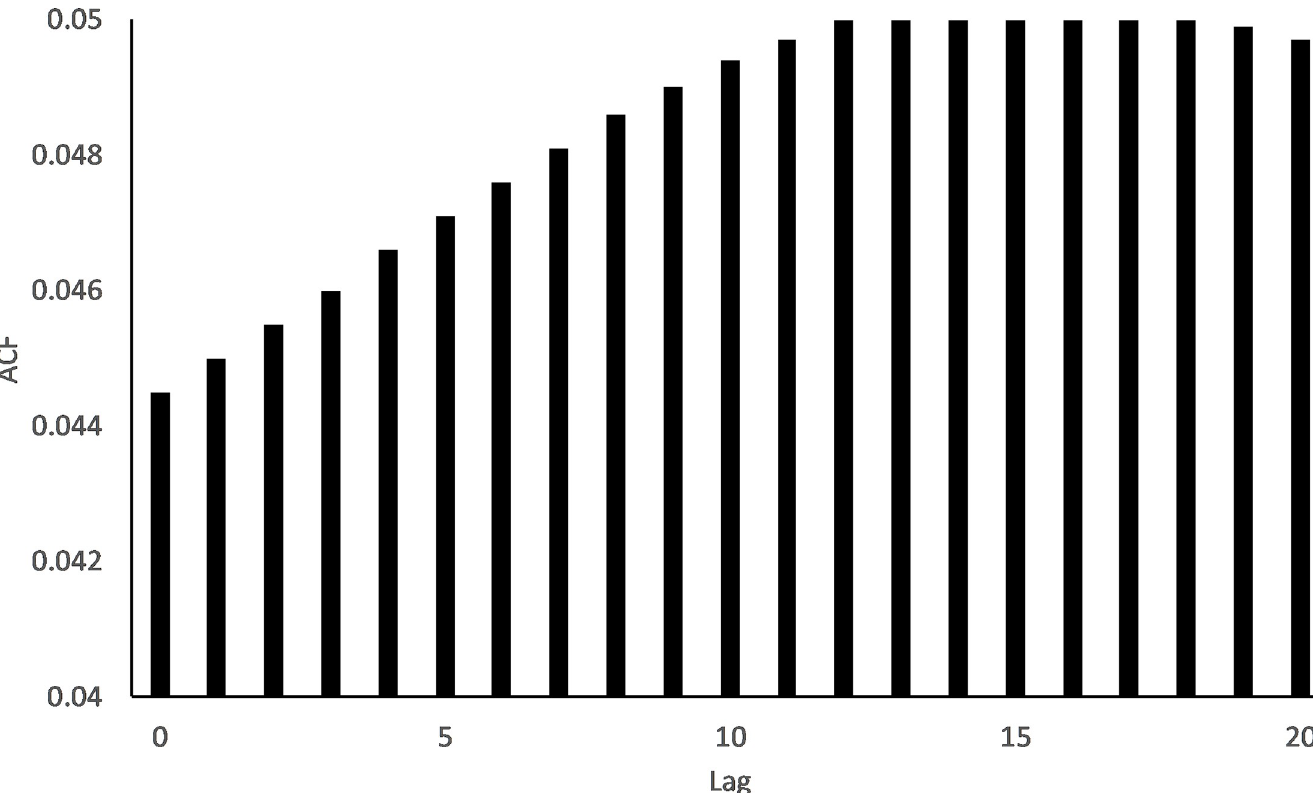
Fig 3. Cross-correlation between tide height and depth measured at the 250m below bund location. Maximum correlation occurs at a lag of 12 to 17 which is equivalent to a 3 to 4.25 hr delay between tides experienced at the coast and measured changes in depth at the 250m below bund location– 15 min data records. 95% CI has been omitted from the graph falling at ±